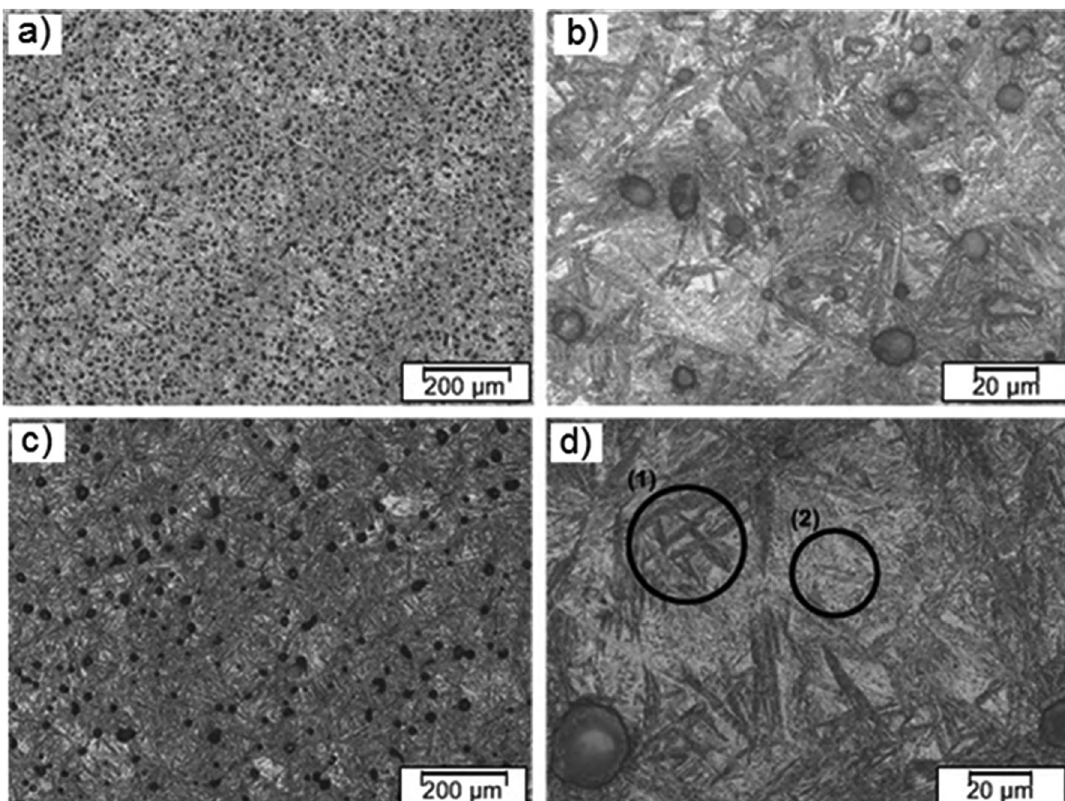
Figure 7. Microstructures of (a-b) pressed and (c-d) injection molded samples sintered at 1400 °C. Optical microscope, Marble